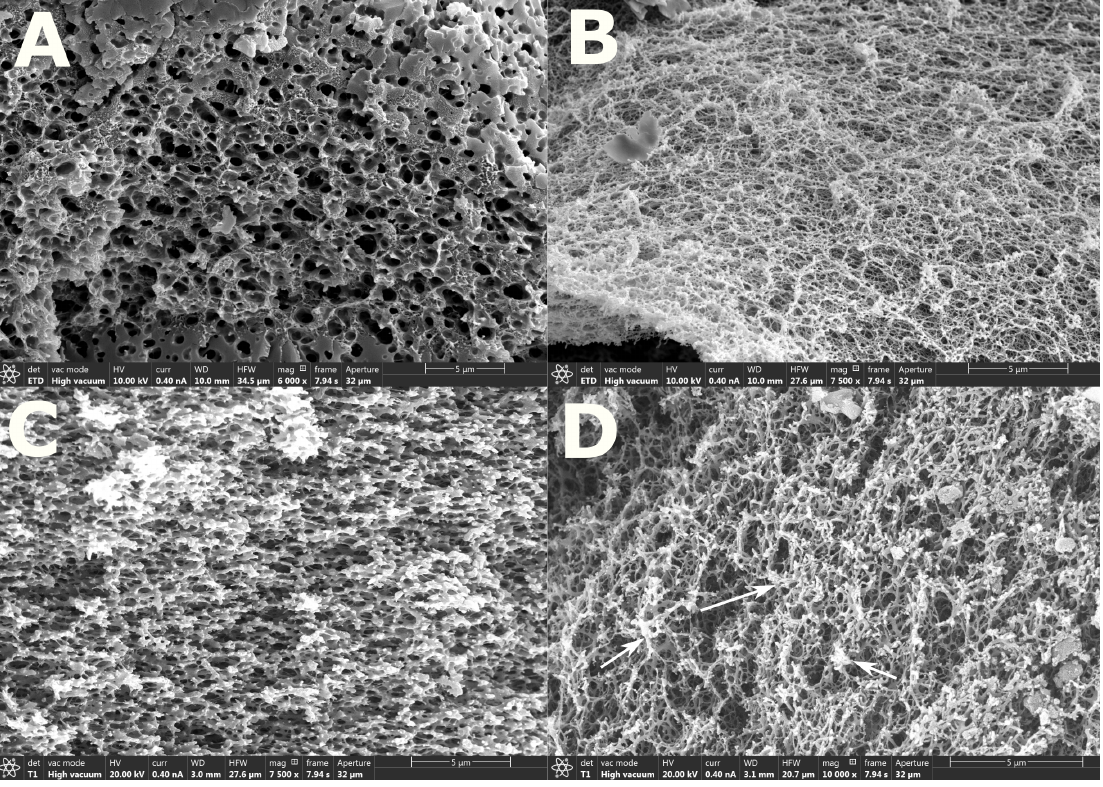
Figure 3. ( A ) SEM image of CPD AAM-AAC-BIS hydrogel without GNRs in SE mode; ( B ) SEM image of CPD AAM-AAC-BIS hydrogel with GNRs in SE mode; ( C ) SEM image of HMDS-dried AAM-AAC-BIS hydrogel without GNP in BSE mode; ( D ) SEM image of HMDS-dried AAM-AAC-BIS hydrogel with GNP in BSE mode. Note that the scalebar in the images is 5 µ m. The white arrows show the small-sized contrast features observed that could indicate GNR